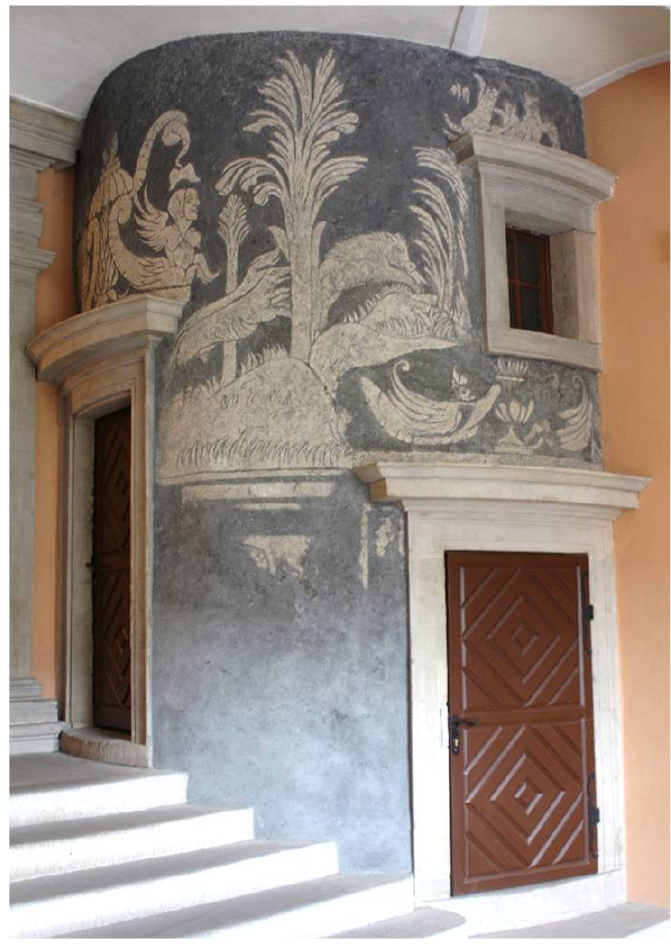
Figure 3. Fragment of the sgraffito decoration of the town hall in Lwówek, preserved inside. Photo by L. Schneider, 2013. Source: Wikimedia Commons: Lwówek Śląski Sgraffito. Available online: https://commons.wikimedia.org/wiki/File:Lw%C3%B3wek_%C5%9Al%C4%85ski_Ratusz_Sgraffit to_(1).JPG (accessed on 15 September 2021).